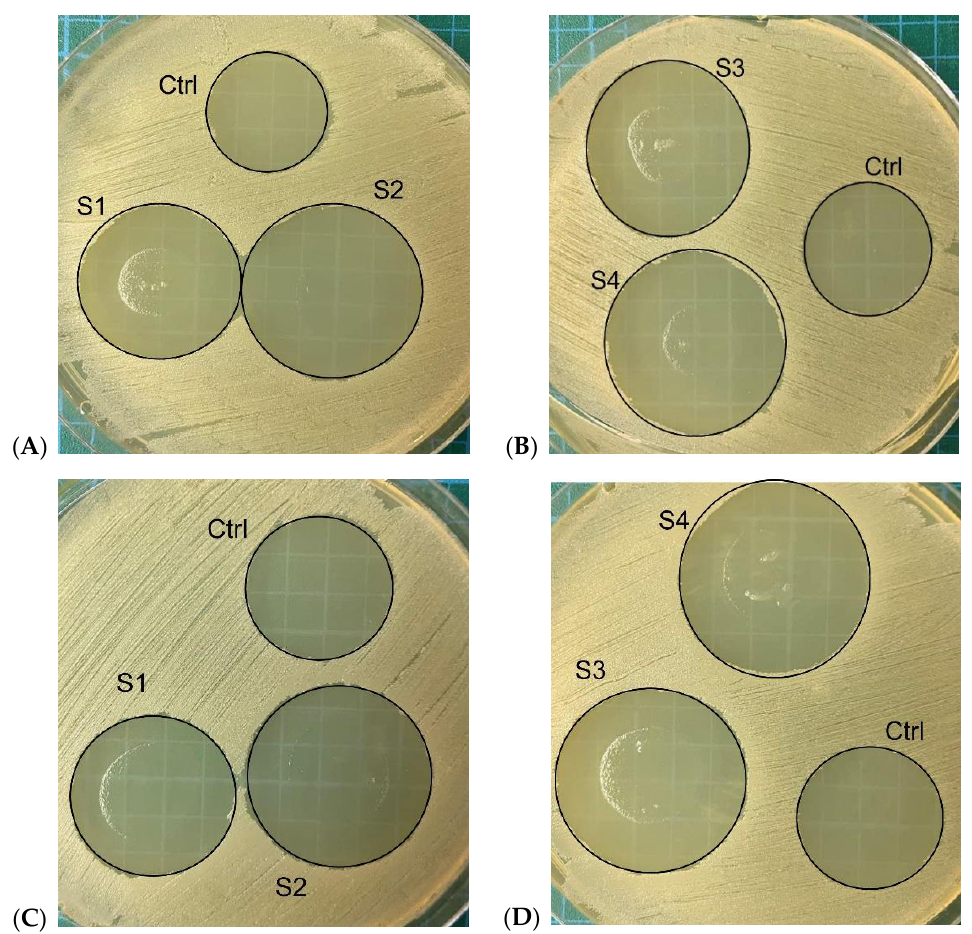
Figure 12. Antibacterial activity test of starch-based materials against E. coli and S. aureus in formu- lations with different weight ratios of ZnO nanoparticles: ( A , B ) images of S1–S4 samples tested against E. coli and their control zones using Penicillin; ( C , D ) images of S1–S4 samples tested against S. aureus and their control zones using Penicillin.